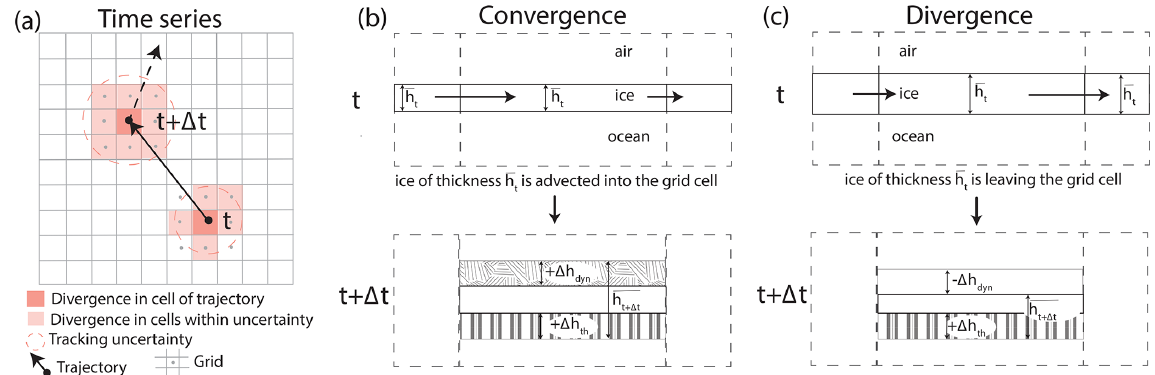
Figure 2. Sketch of the simple ice thickness model showing the vertical cross section of thickness change between time steps t and t + (cid:49)t . (a) Trajectories on deformation grid. The deformation grid defines the grid cells as sketched in (b) and (c) . Divergence is extracted from all grid cells whose center points (gray dots) are located in the uncertainty range given by the increasing accumulated trajectory position error (dashed circle). (b) In the case of convergence, ice with a mean grid cell thickness h t is advected into the grid cell, resulting in a volume-conserving thickness increase ( + (cid:49)h dyn ). (c) In the case of divergence, ice with a mean thickness h t leaves the grid cell, reducing ice thickness dynamically by − (cid:49)h dyn . Thermodynamic growth + (cid:49)h th continues unabatedly in (b) and (c) , independently of